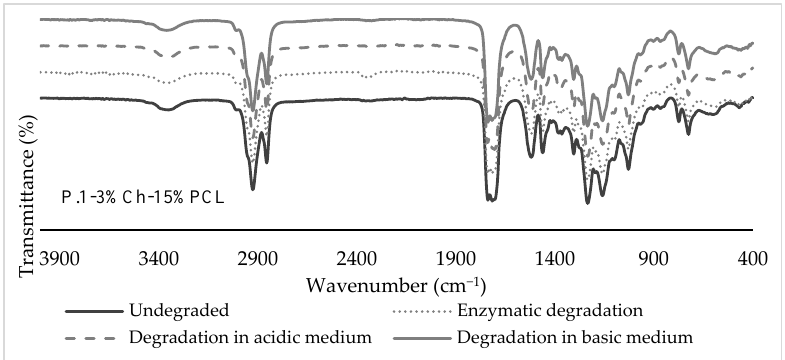
Figure 10. FTIR spectra of PUs degraded in acidic, basic, and enzymatic media.